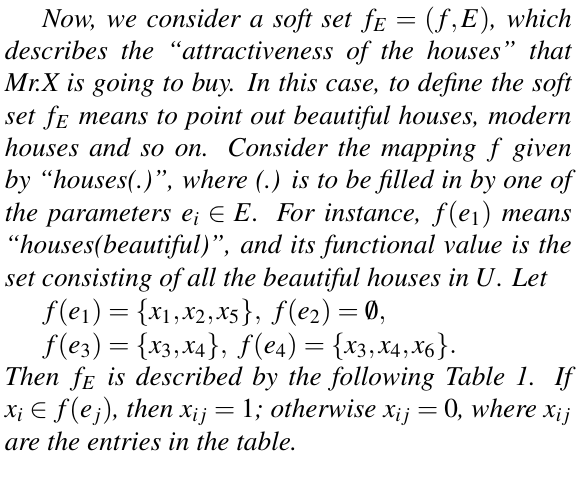
Table 1. Tabular representation of the soft set f